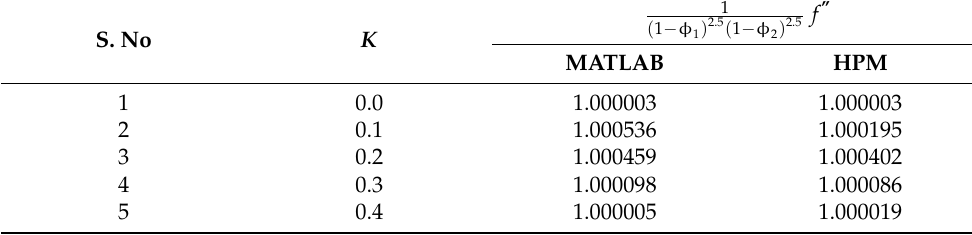
Table 2. Comparison of results of K with MATLAB and HPM